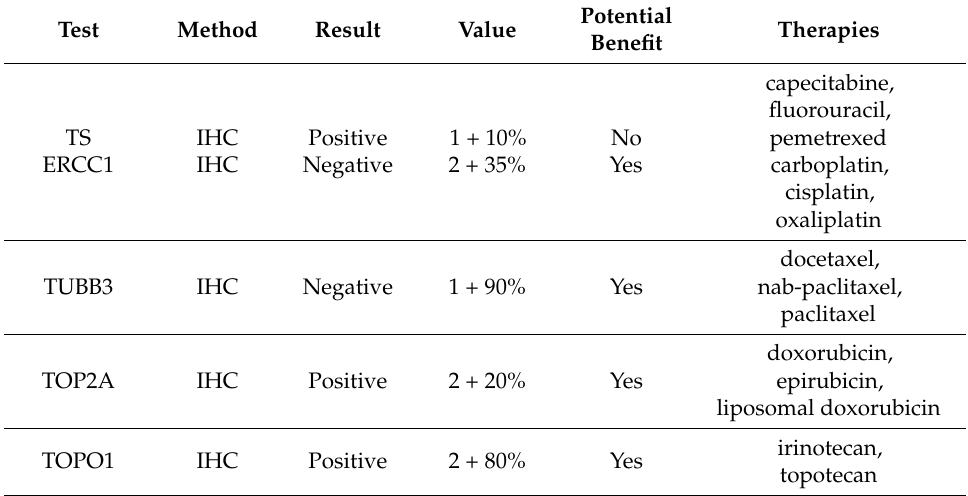
Table 3. Biomarker analysis and associated